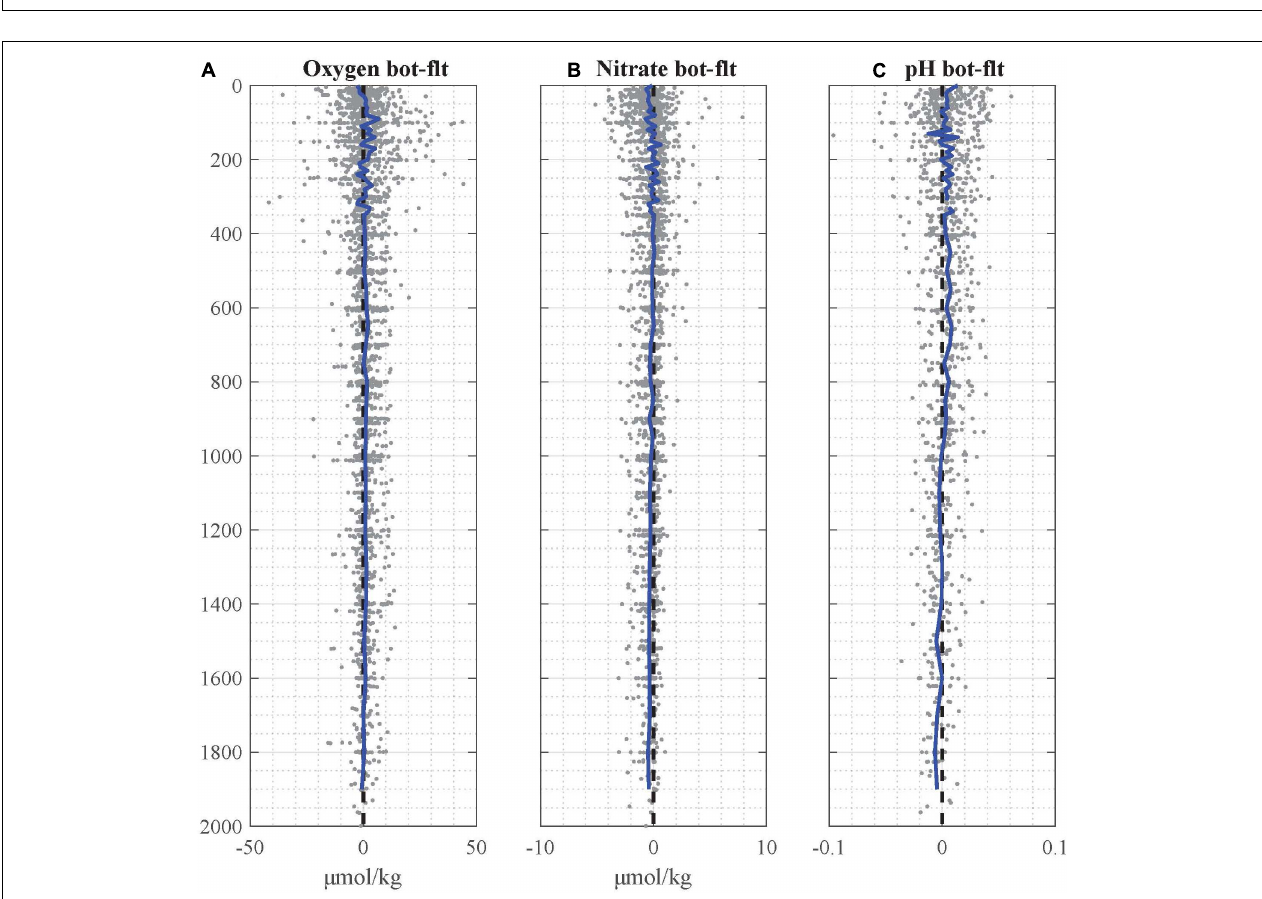
FIGURE 13 | Scatterplots of bottle minus float matchups for adjusted (A) oxygen, (B) nitrate, and (C) pH data, plotted in depth space. Blue lines represent the mean of data within depth bins.